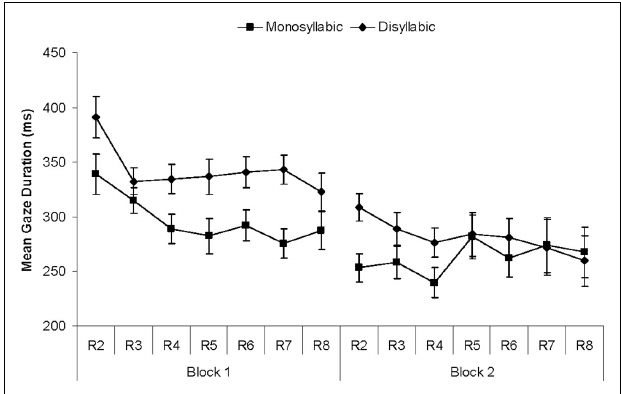
FIGURE 4 | Results of Experiment 1. Mean gaze durations (ms) per block and repetition (R2 through R8) for monosyllabic and disyllabic items.